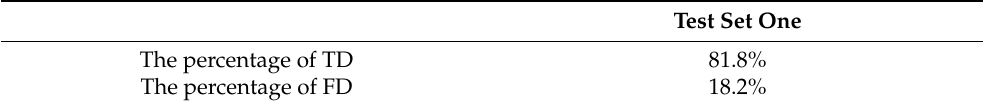
Table 6. The performance of multidimensional information processing